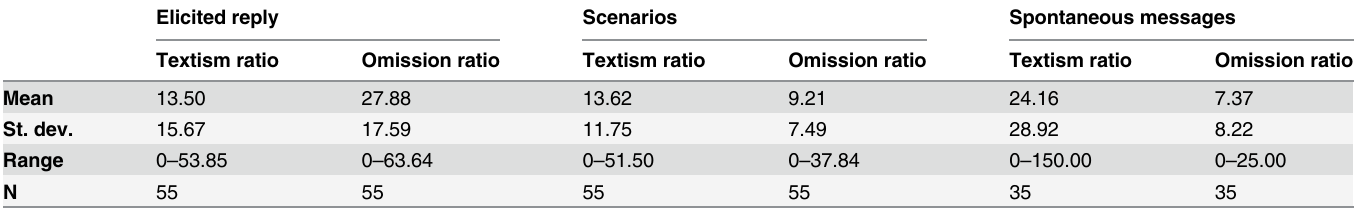
Table 3. Means, standard deviations and ranges of children ’ s use of textese in various types of messages. Elicited reply